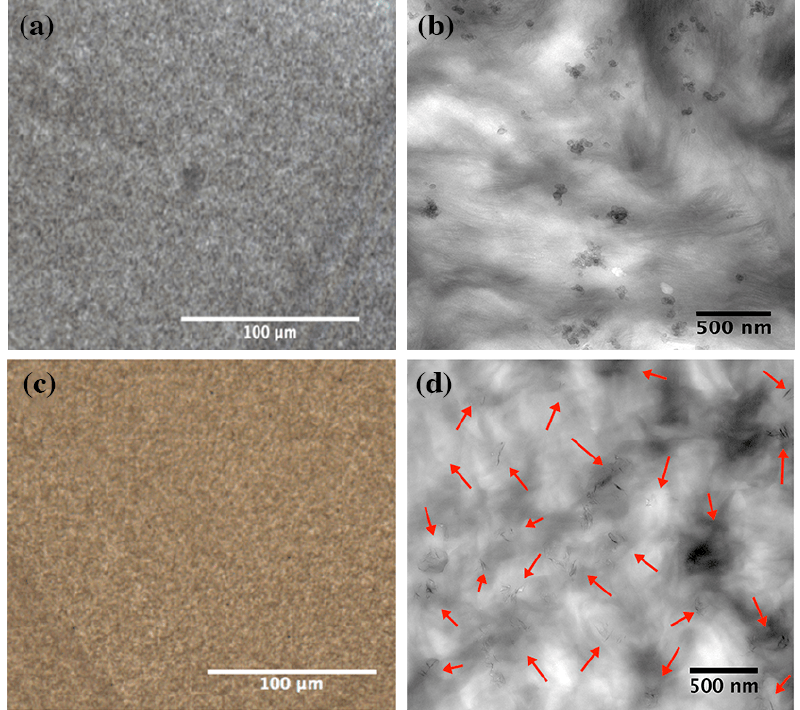
Figure 1. Light microscopy ( left ) and TEM images ( right ) show the dispersion and distribution of ( a , b ) carbon black and ( c , d ) graphene platelets within the multimodal-HDPE matrix. The red arrows show the distribution of graphene platelets throughout the polymer matrix. The TEM and light microscopy images were taken at 10k and 20×, respectively.